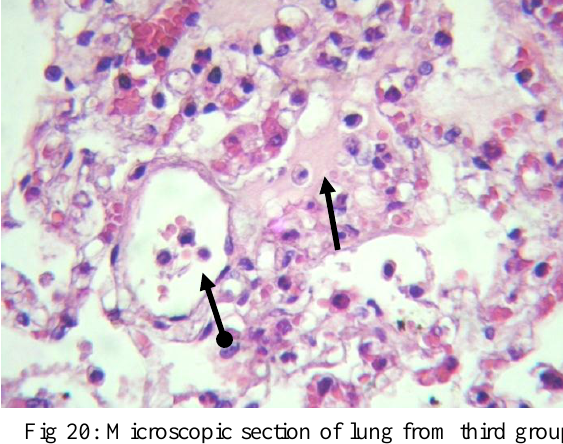
Fig 20: Microscopic section of lung from third group during 24–48 hrs show homogenous portentous substances in the alveolar lumen with cellular infiltration in the alveoli & blood vessel (H&E X20).